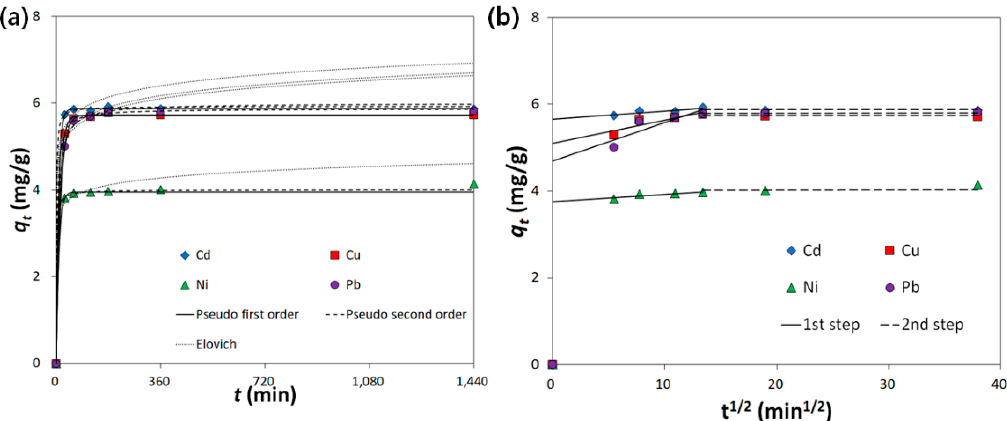
Figure 5. Kinetic sorption of Cd 2+ , Cu 2+ , Ni 2+ , and Pb 2+ by 1 M NaOH-treated H. fusiformis : ( a ) pseudo-first-order, pseudo-second-order, and Elovich models, and; ( b ) intraparticle diffusion model. Table 2. Pseudo-first-order, pseudo-second-order, and Elovich model parameters for heavy metal biosorption on 1 M NaOH-treated H. fusiformis .